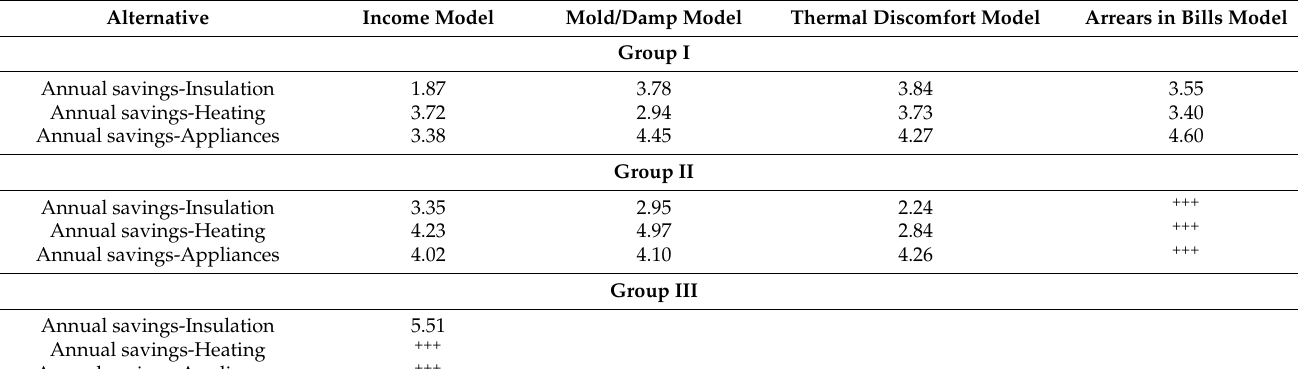
Table 5. MWTP estimates for the split models per group.